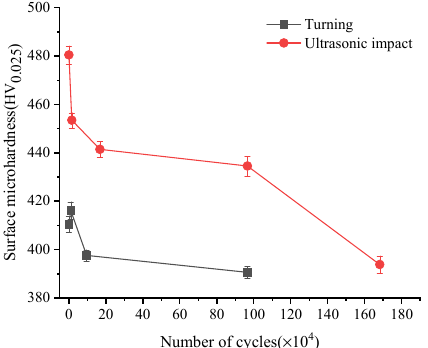
Figure 9. Surface microhardness evolution during the fatigue process.